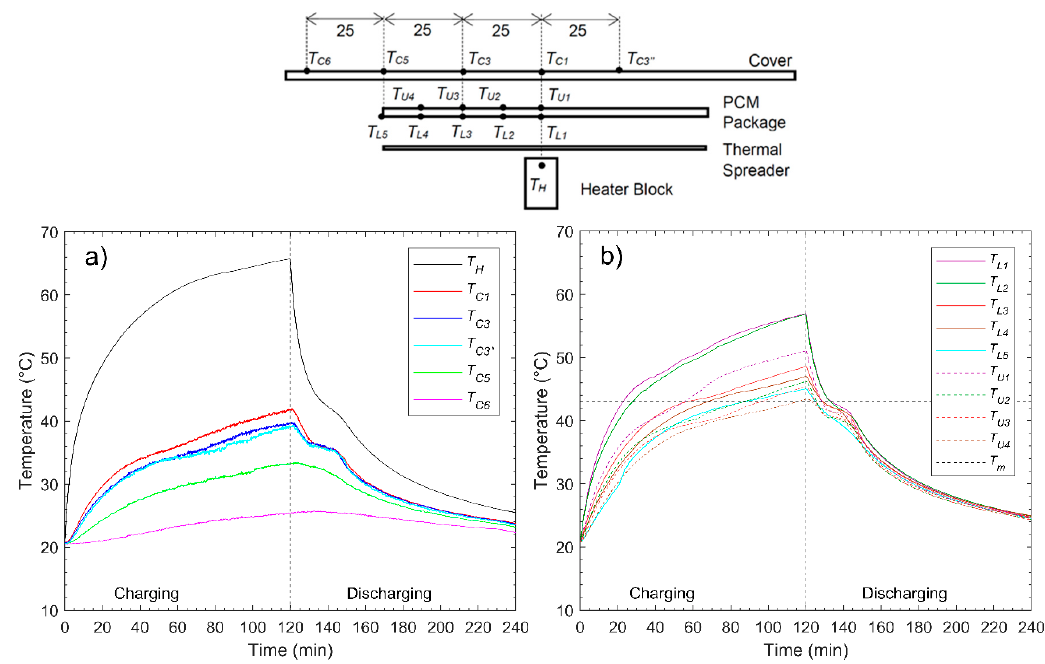
Figure 8. ( a ) Temperature profile of the heater ( T H ) and the cover surface ( T C ). ( b ) Temperature profiles of the upper ( T U1 –T U4 ) and lower ( T L1 –T L5 ) surface of the PCM package B (dodecanoic acid) and the thermal spreader for the experiment with a constant power input of 5 W for 120 min.